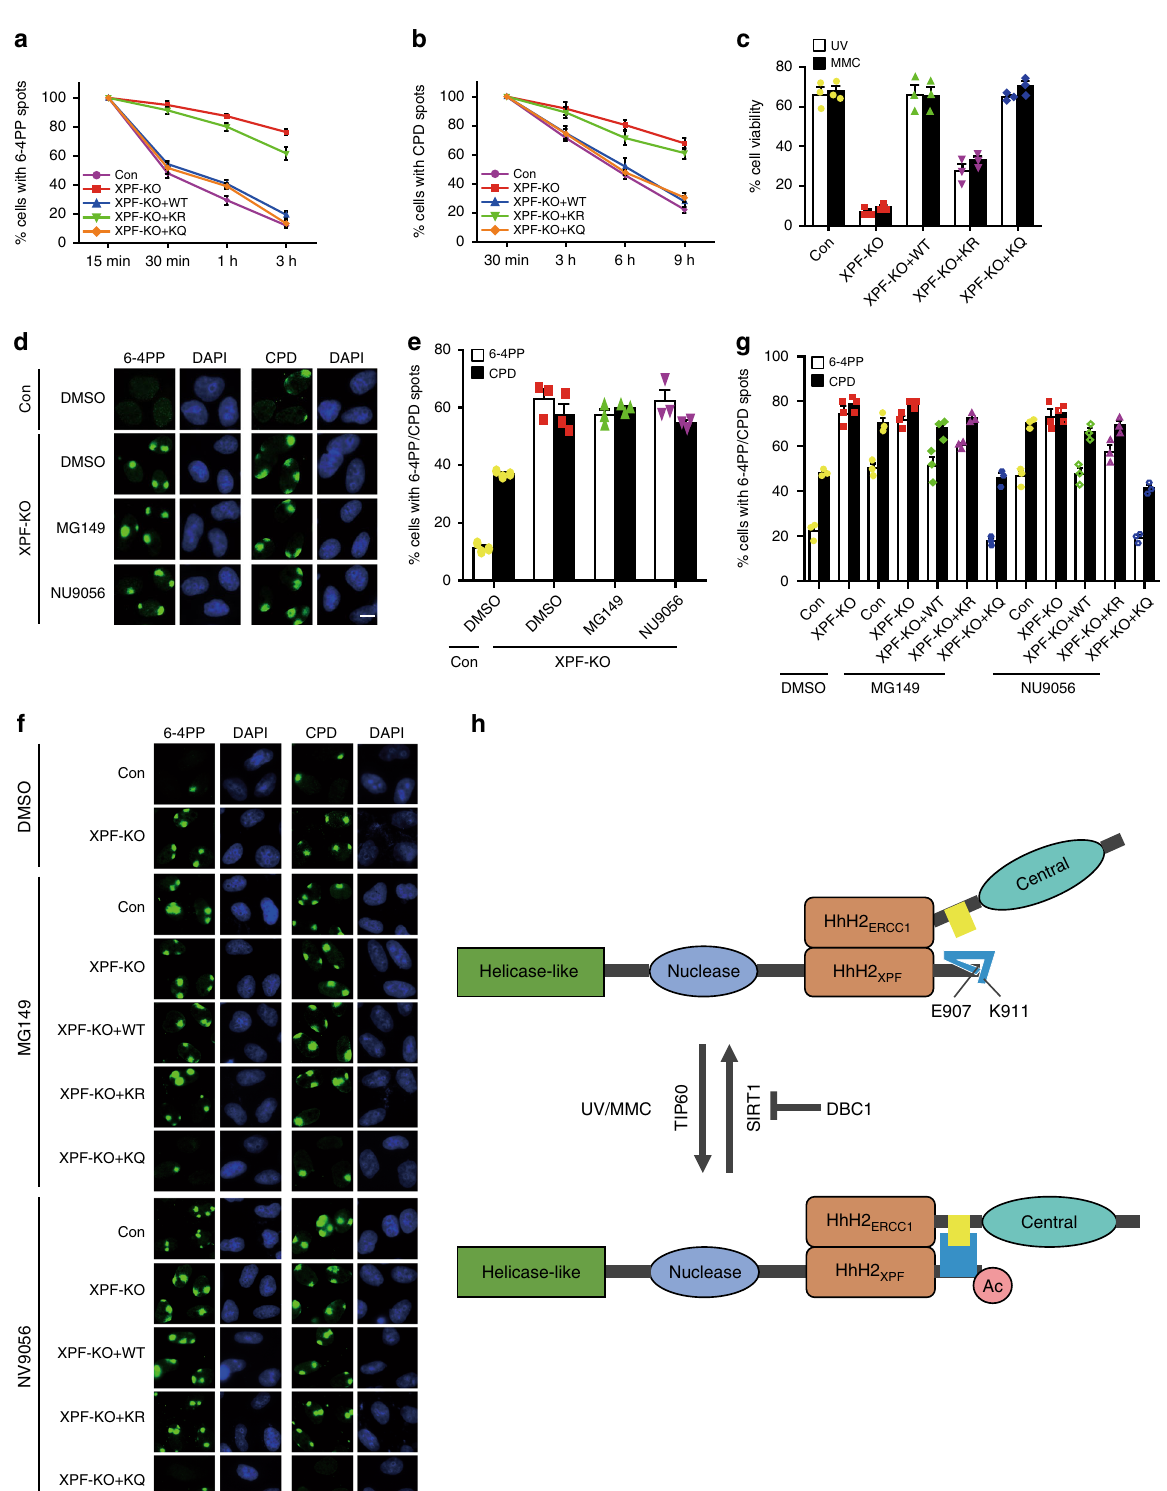
While UV irradiation or MMC treatment is able to trigger a strong dose-dependent induction of XPF acetylation, other DNA- damaging agents, such as IR, fail to do so. However, upon exposure to IR, TIP60 is activated. IR can also induce the inter- action between SIRT1 and its inhibitor DBC1. These results indicate that, in addition to activating TIP60 and inhibiting SIRT1, there are likely other mechanisms involved in the